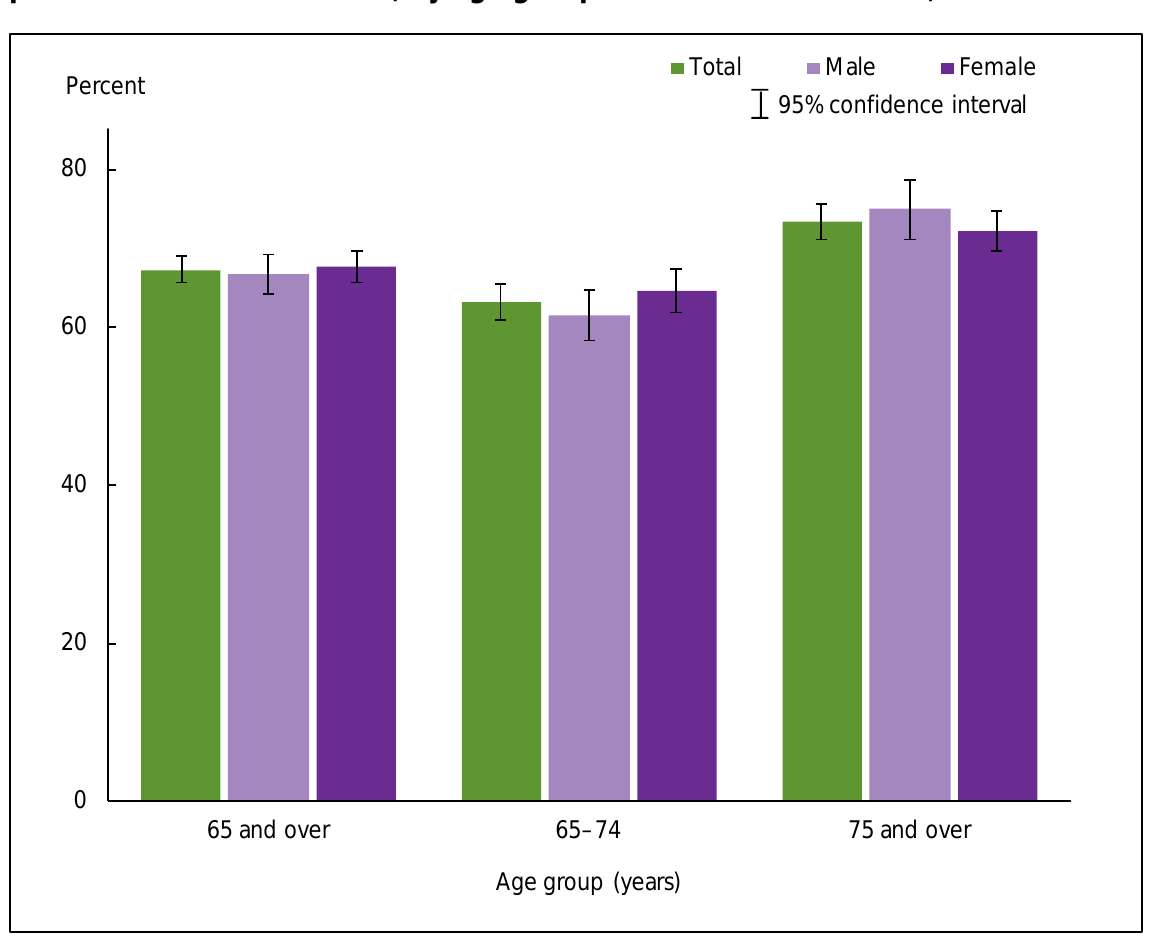
Figure 5.2. Percentage of adults aged 65 and over who had ever received